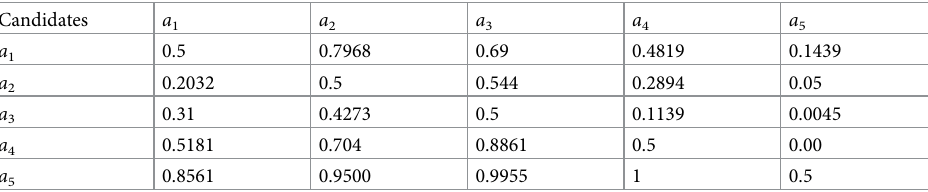
Table 4. Possibility matrix of the five candidates in the manager selection